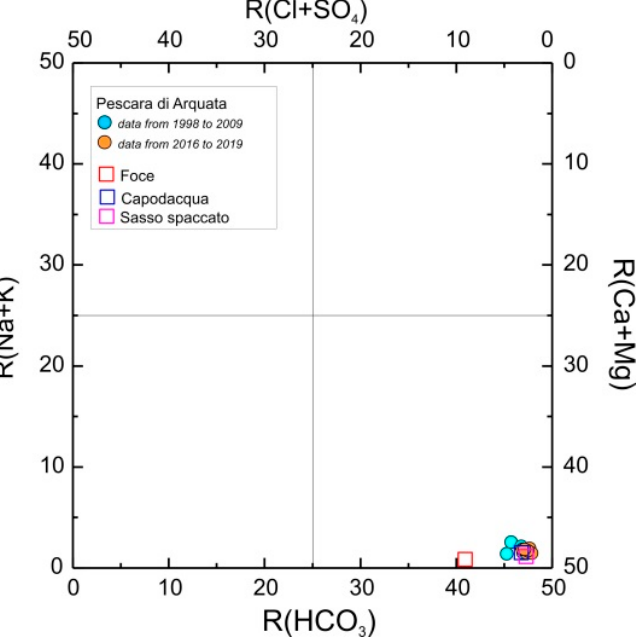
Figure 3. Langelier–Ludwig diagram showing the chemical composition of Pescara di Arquata spring water from 1998 up to 2019 and that of springs located nearby. The blue circles refer to the 1998–2001 period, whereas the orange circles refer to the period from 2016 to 2019.